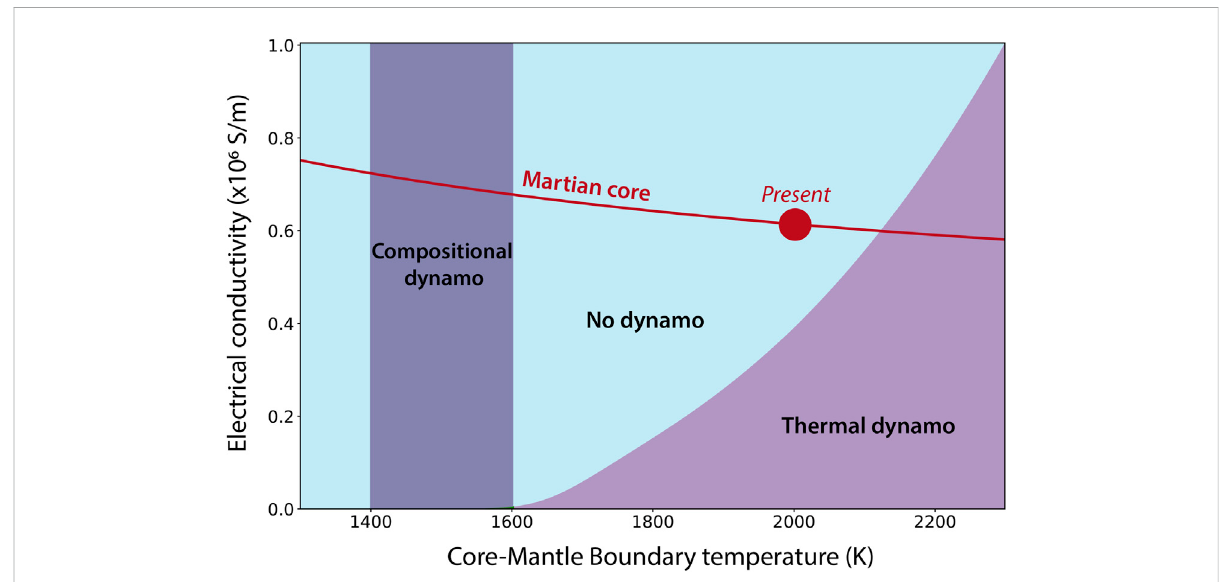
FIGURE 12 Martian dynamo regimes in electrical conductivity - temperature space. The model of Driscoll and Du (2019) is applied to Mars, with the upper conductivity limit for thermal convection (grey curve) from their Equation 13, assuming k LM =5 W/m/K, α =2.5 × 10 − 5 K − 1 , g=3.721 m/s 2 ρ LM =3,550 kg/ m 3 , c m =798 J/kg/K, and ν ref =1.1749 × 10 10 m 2 /s. The nominal present-day Martian core state is assumed to be T CMB =2,000 K, thermal conductivity k=30 W/m/K, corresponding to electrical conductivity σ =6.14 × 10 5 S/m (red circle). The central core solidi fi cation temperature from Figure 1 for Fe-10S (Chen et al., 2008) is extrapolated along a core adiabat to the core-mantle boundary (CMB) to estimate T CMB at which core solidi fi cation begins, ~1,600 K, and full core solidi fi cation occurs, ~1,400 K (blue region).